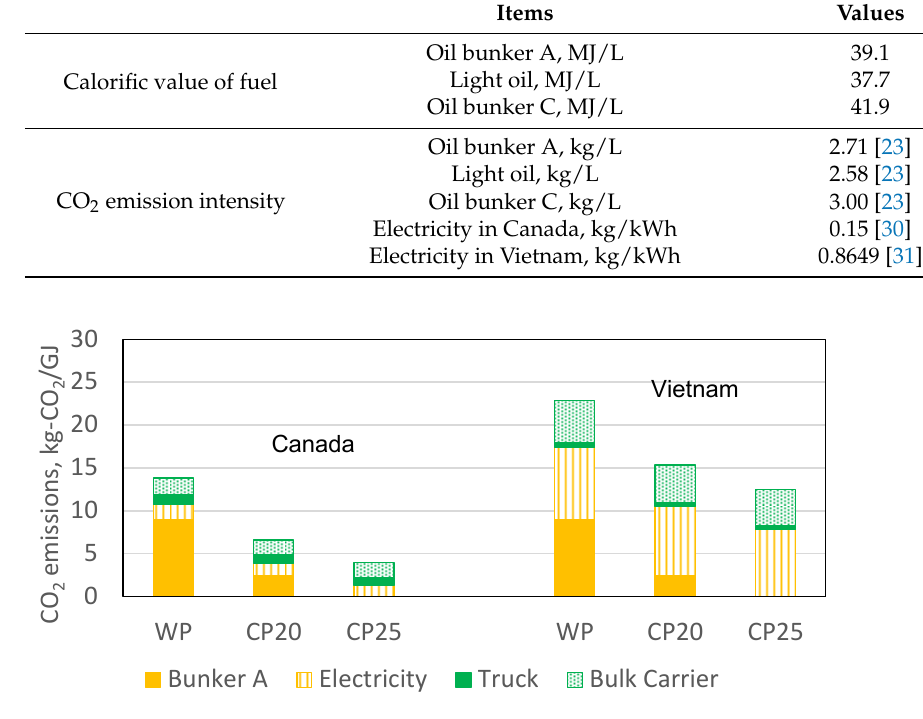
Figure 3. CO 2 emissions of WP and CP.